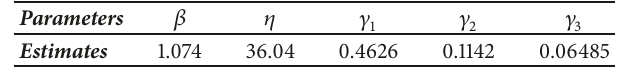
Table 1: Parameters of